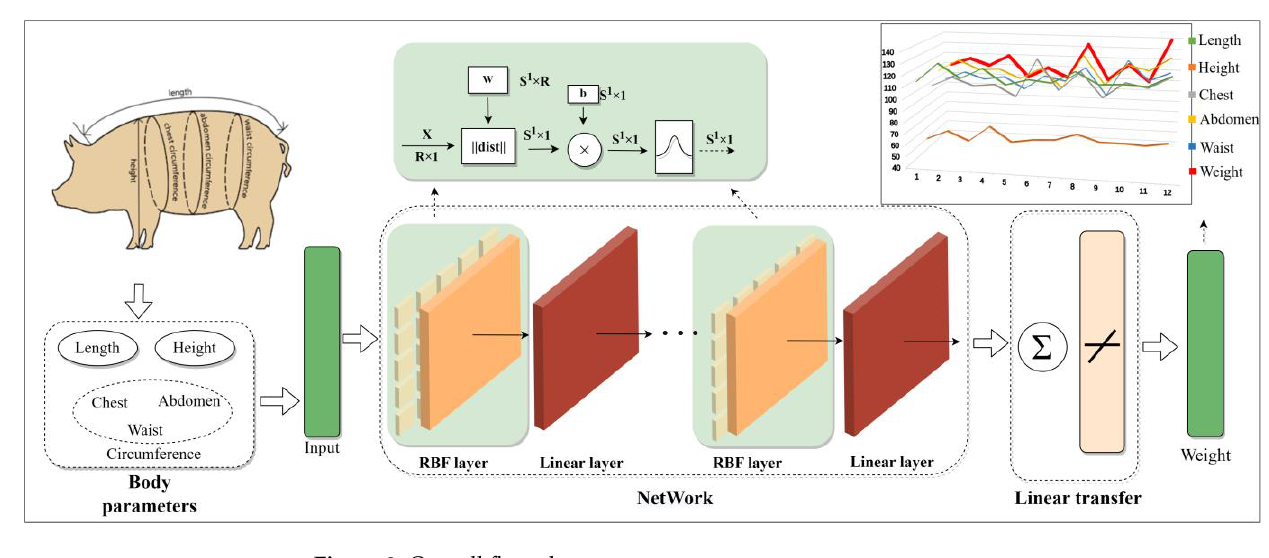
Figure 3. Overall flow chart.